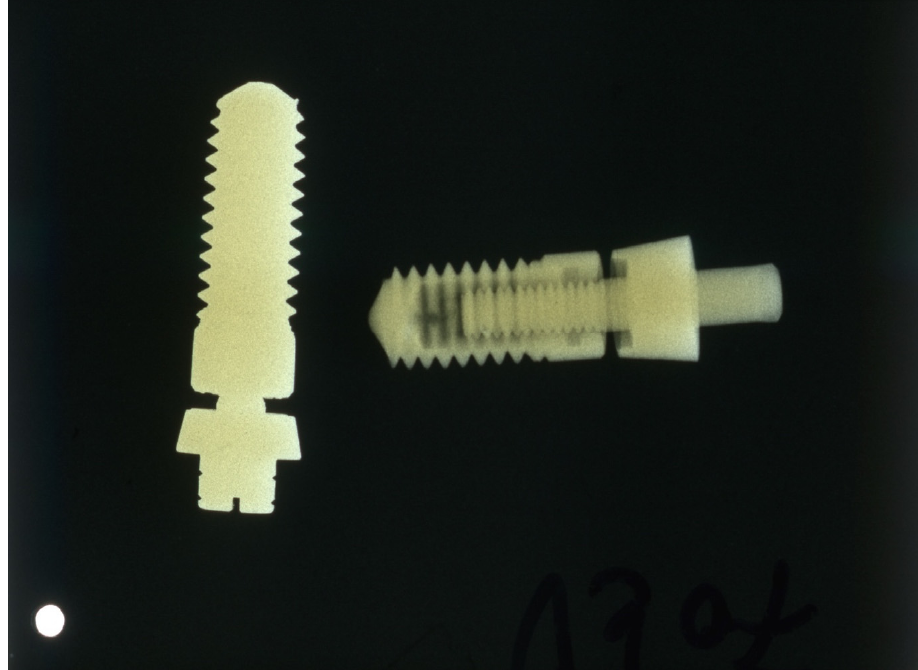
Figure 1. X-ray of tantalum ( left ) and titanium ( right ) implants; the density of the tantalum implant is much higher.